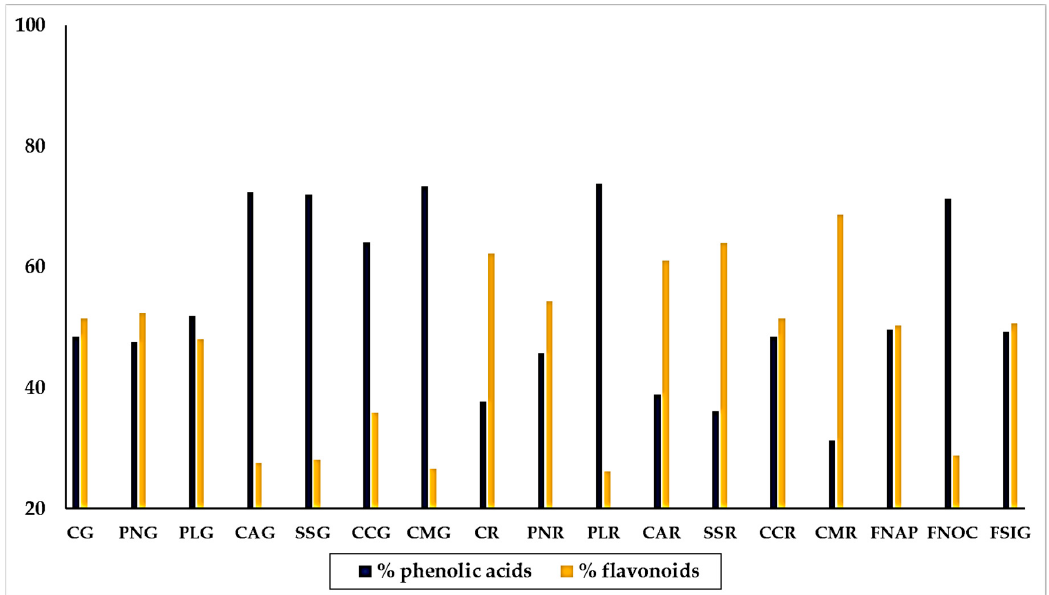
Figure 5. Distribution of phenolic acids and flavonoids and phenolic acids, respect to the molecules recognized by UPLC, in yellow, red and green traditional varieties of sweet pepper of the Campania Region. Varieties = CG: Cazzone, yellow; PNG: Papaccella napoletana, yellow; PLG: Papaccella liscia, yellow; CAG: Cornetto di Acerra, yellow; SG: Sassaniello, yellow; CCG: Corno di Capra, yellow; CMG: Corno Marconi, yellow; CR: Cazzone, red; PNR: Papaccella napoletana, red; PLR: Papaccella liscia, red; CAR: Cornetto di Acerra, red; SR: Sassaniello, red; CCR: Corno di Capra, red; CMR: Corno Marconi, red; FNAP: Friariello Napoletano, green; FNOC: Friariello Nocerese, green; FSIG: Friariello Sigaretta, green.